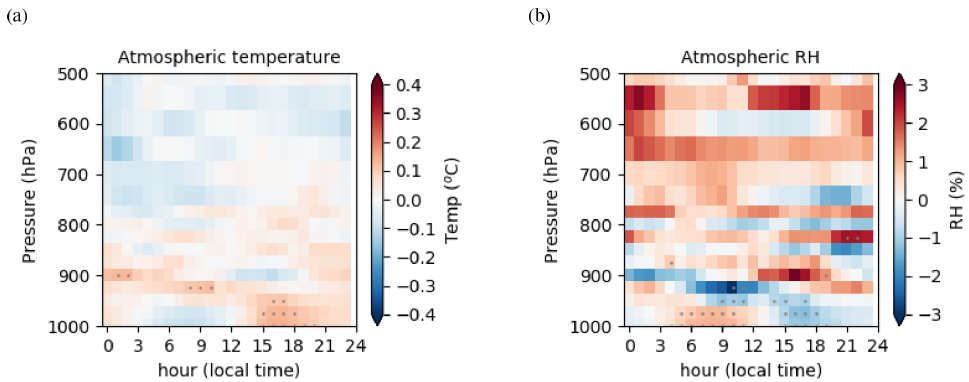
Figure 7. Change in mean daily cycle between the experiment with hourly SST forcing (Atm SSTObs 1h) and the experiment with daily SST forcing (Atm SSTObs 1d) for (a) the atmospheric temperature ( ◦ C) and (b) relative humidity (%). Dots indicate significant anomalies according to a Student’s t test at the 95% significance